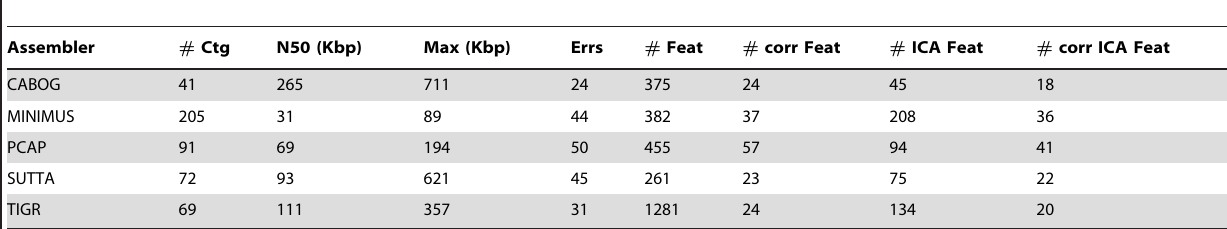
Table 2. Assembly Comparison Real Long Reads: Brucella suis.